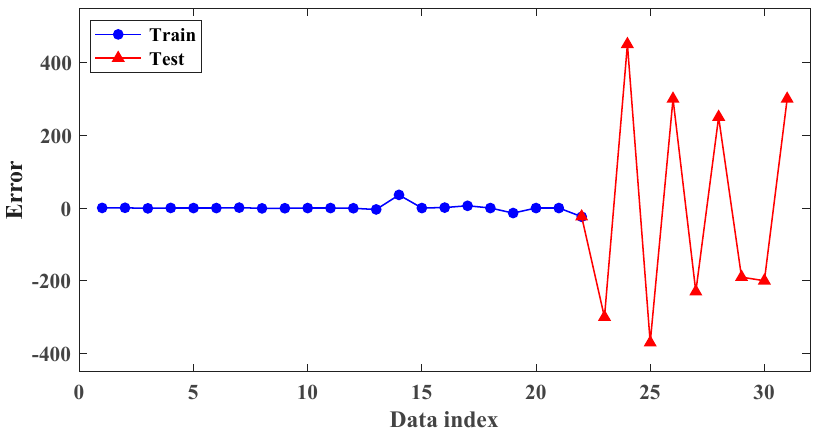
Figure 11. Error of experimental and predicted data.